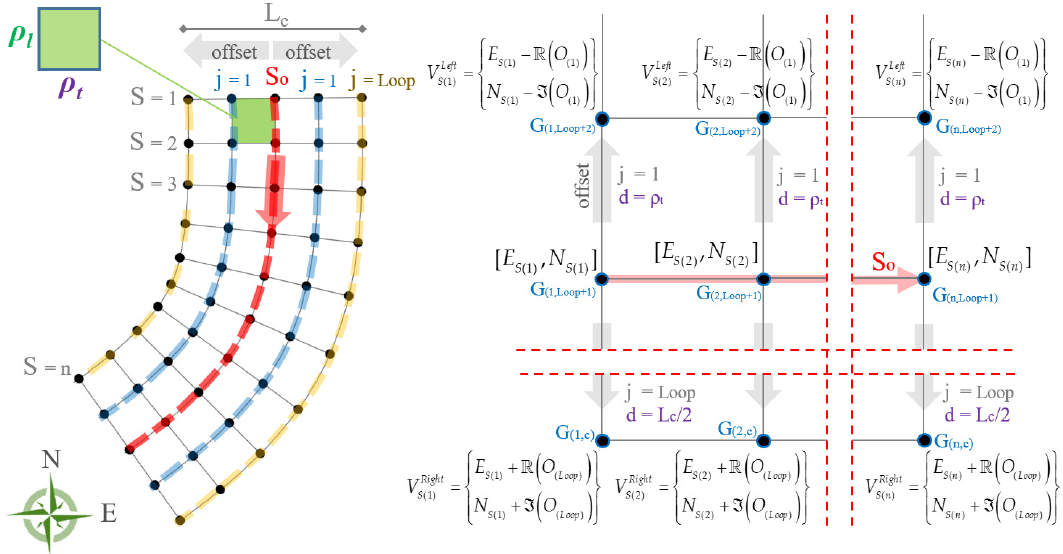
Figure 6. Schematic drawing of planimetric grid node generation.